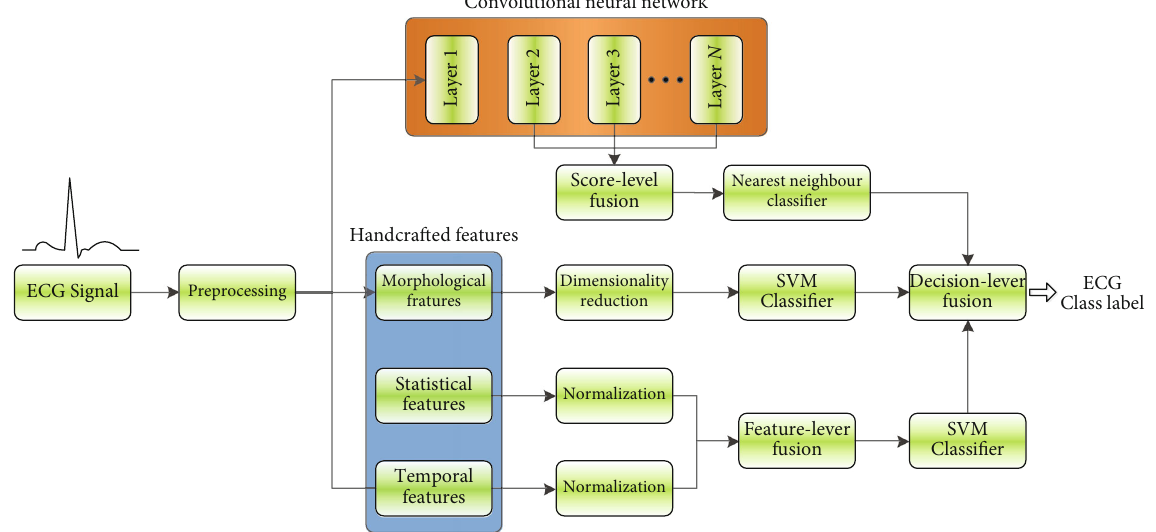
Figure 6: The schematic of the method proposed in [94]. (ECG: electrocardiography.)